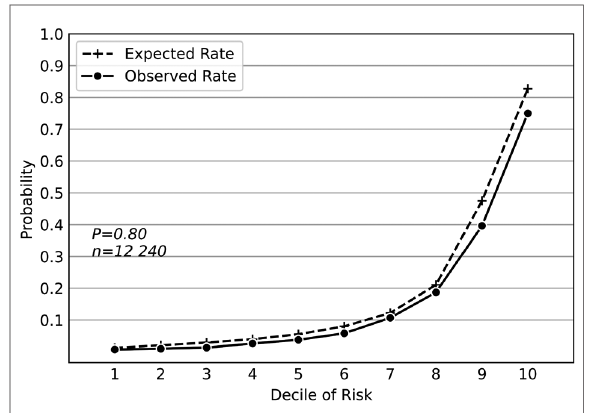
FIGURE 1 Hosmer-Lemeshow calibration plot of the deep neural network model based on the derivation dataset. Values on the x -axis are deciles of predicted risk of postoperative pulmonary complications and values on the y-axis are rates of postoperative pulmonary complications for each decile. The result of Hosmer – Lemeshow test ( P =0.80) showed good agreement between the deep neural network model-based prediction and observed